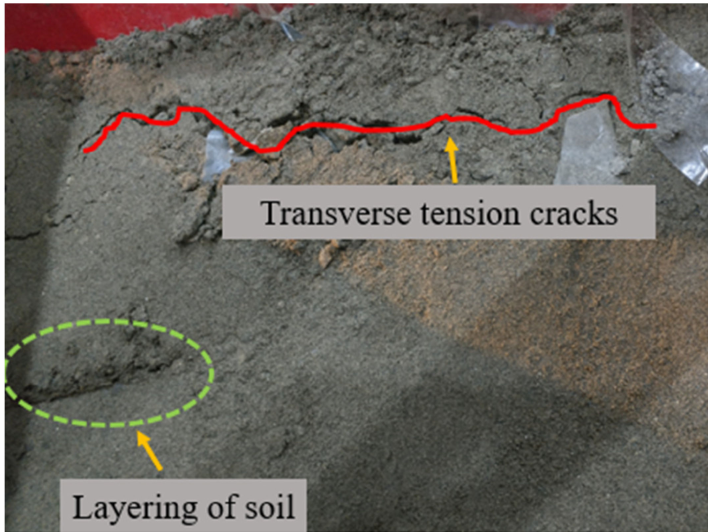
Figure 12. Slope top after 0.4 g sine wave loading.